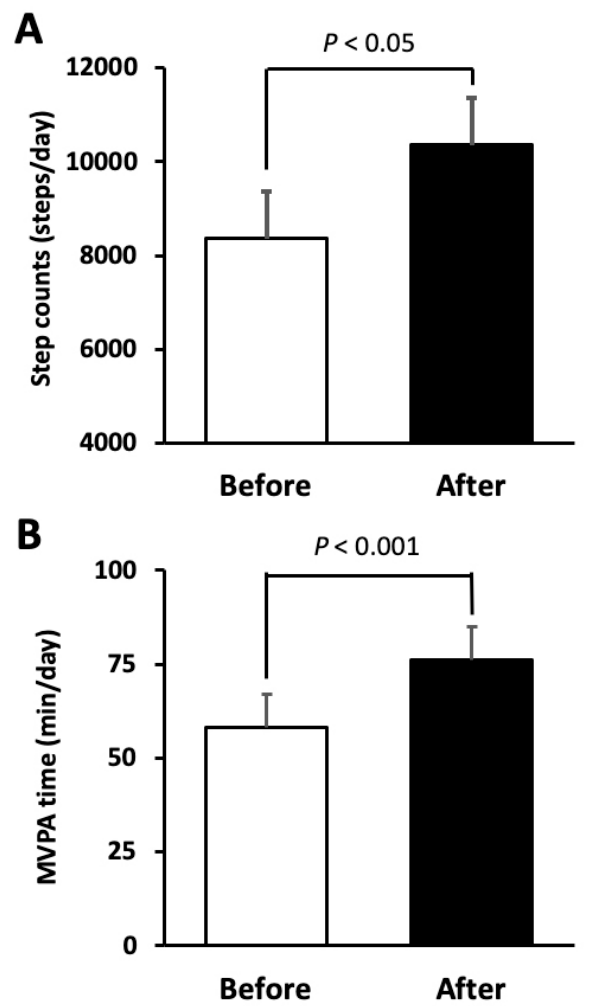
Fig. 2. Physical activity before and after 12-week aerobic ex- ercise training. Data are presented means ±